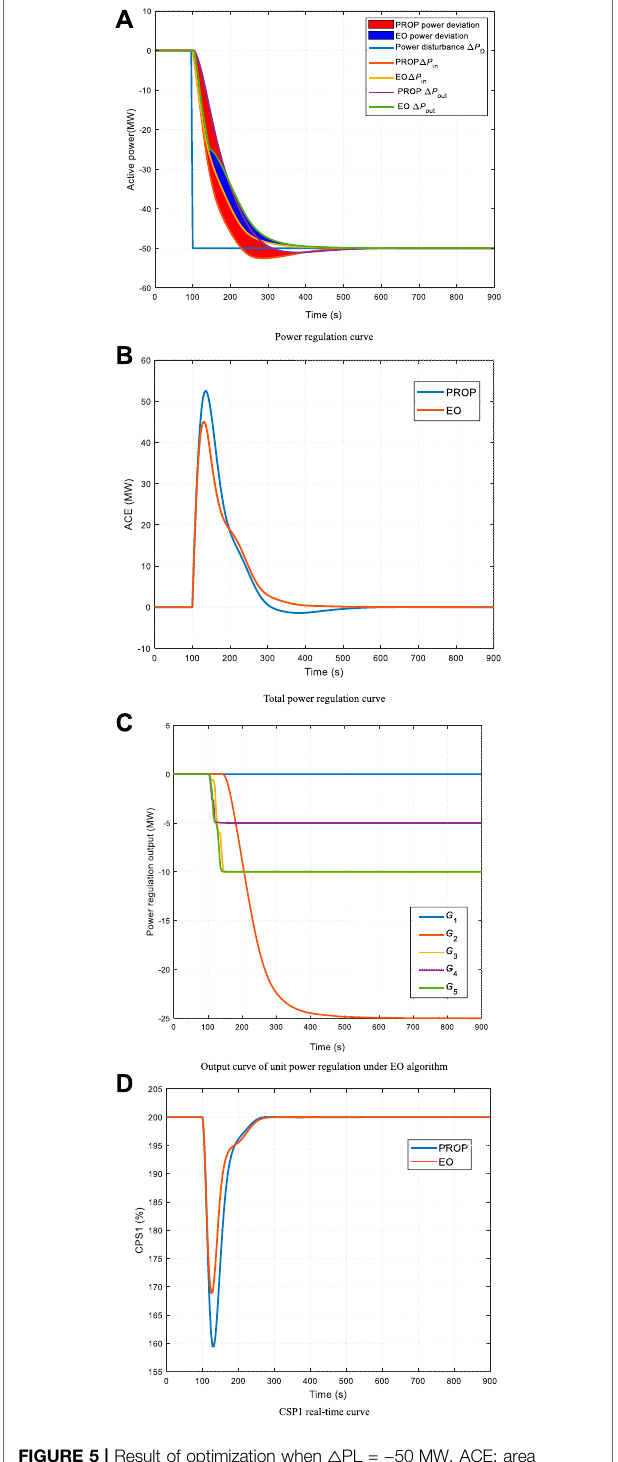
FIGURE 5 | Result of optimization when △ PL = − 50 MW. ACE: area control error; CPS: control performance standard.